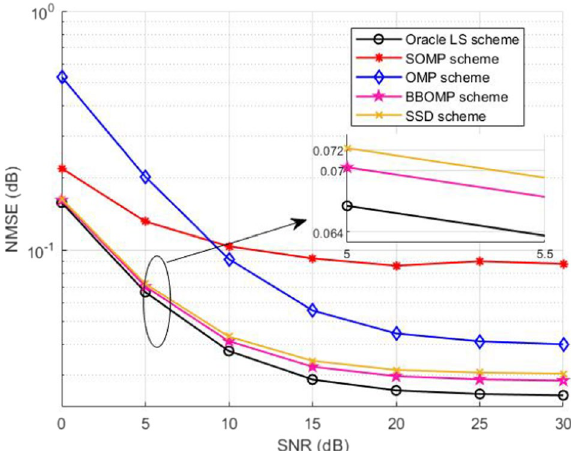
Fig. 4 The NMSE performance of different schemes under different SNR